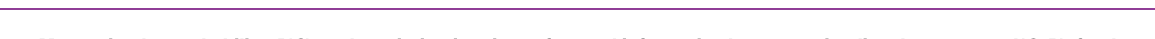
Table 1. Mean stimulus probability, P ( S ), and a priori estimations of mutual information between stimuli and responses, I ( S , R ), for the 3 tasks in Figure 1. Shannon’s (1948) joint entropy H x